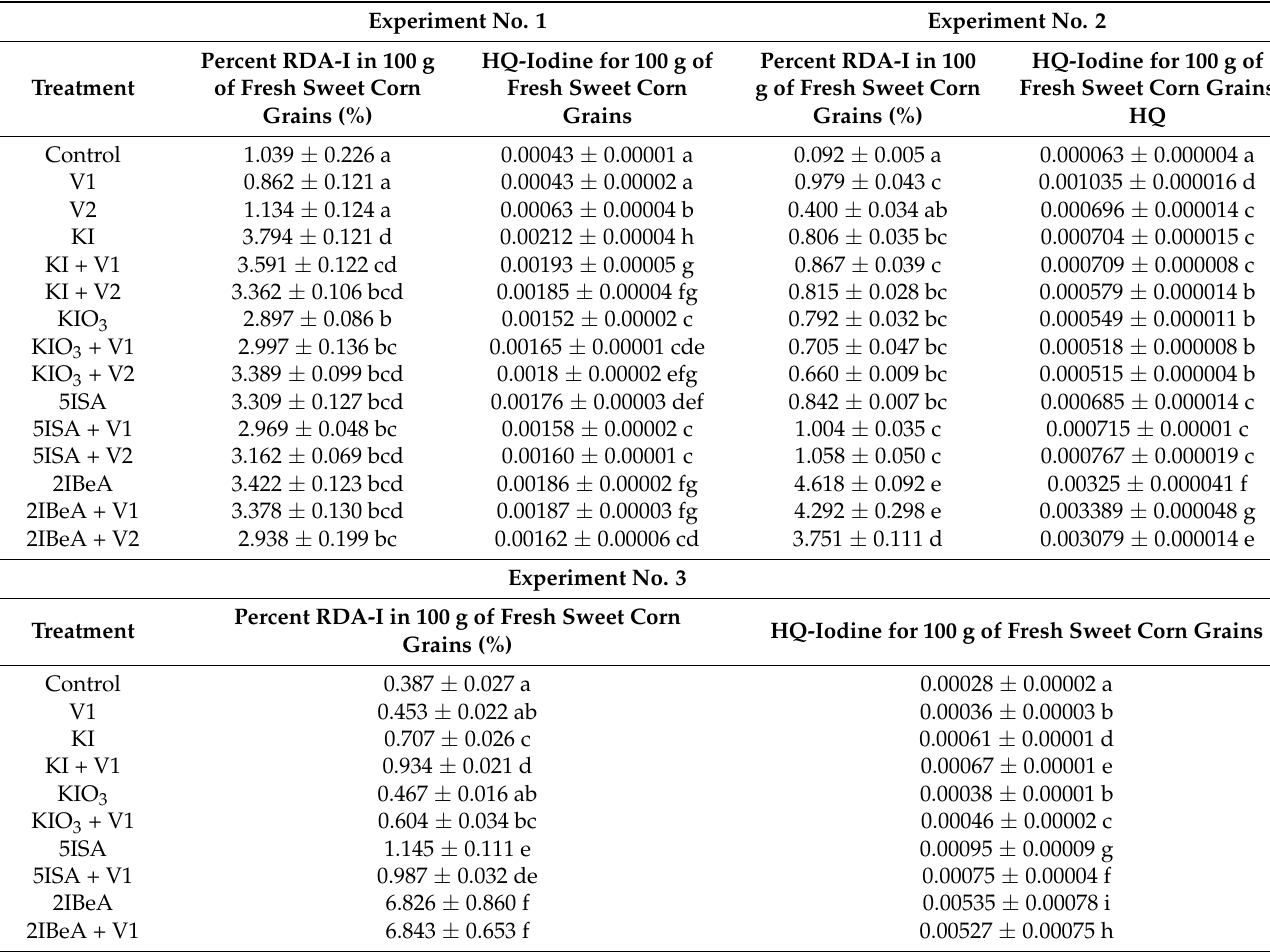
Table 5. Percentage of the recommended daily allowance (RDA) for iodine (RDA-I) in a 100 g portion of fresh grains of sweet corn and the hazard quotient (HQ) for intake of I through the consumption of 100 g of fresh grains of sweet corn by adults (70 kg body weight), depending on the foliar application of iodine and vanadium in experiments No. 1, 2 and